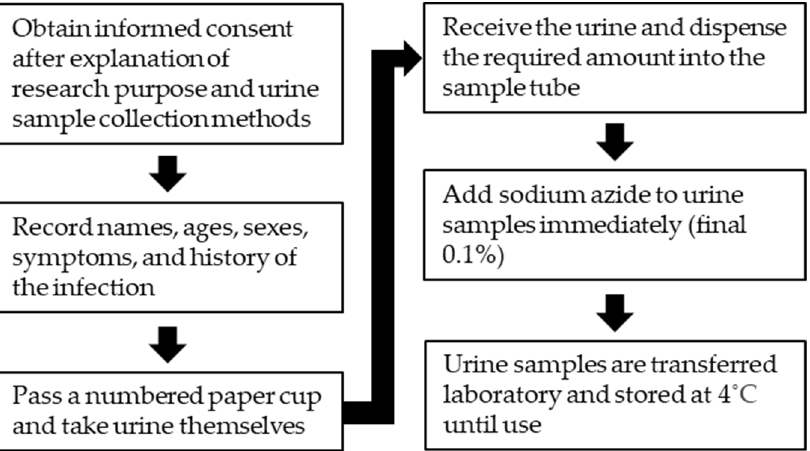
Figure 2. An example of a urine sample collection procedure.